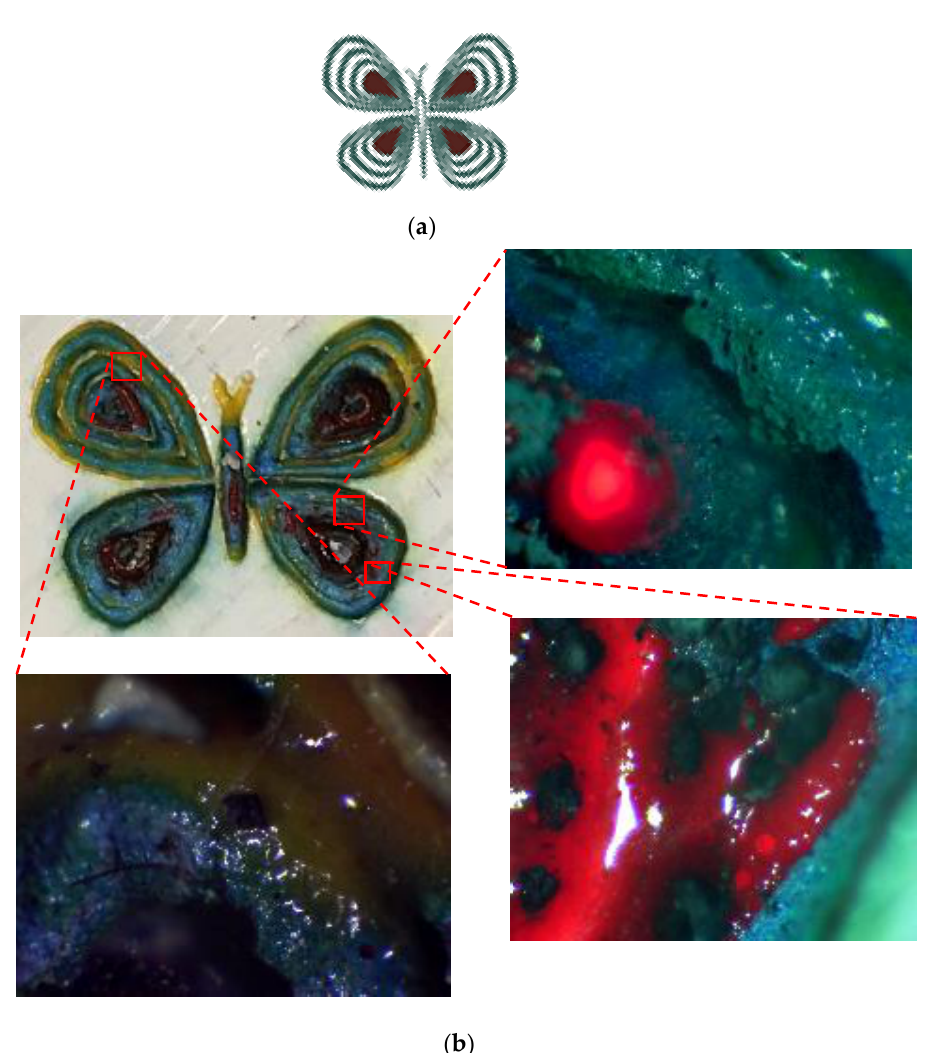
Figure 18. ( a ) CAD design of butterfly. ( b ) Captured micrographs from different sections of laser-decolorized butterfly.